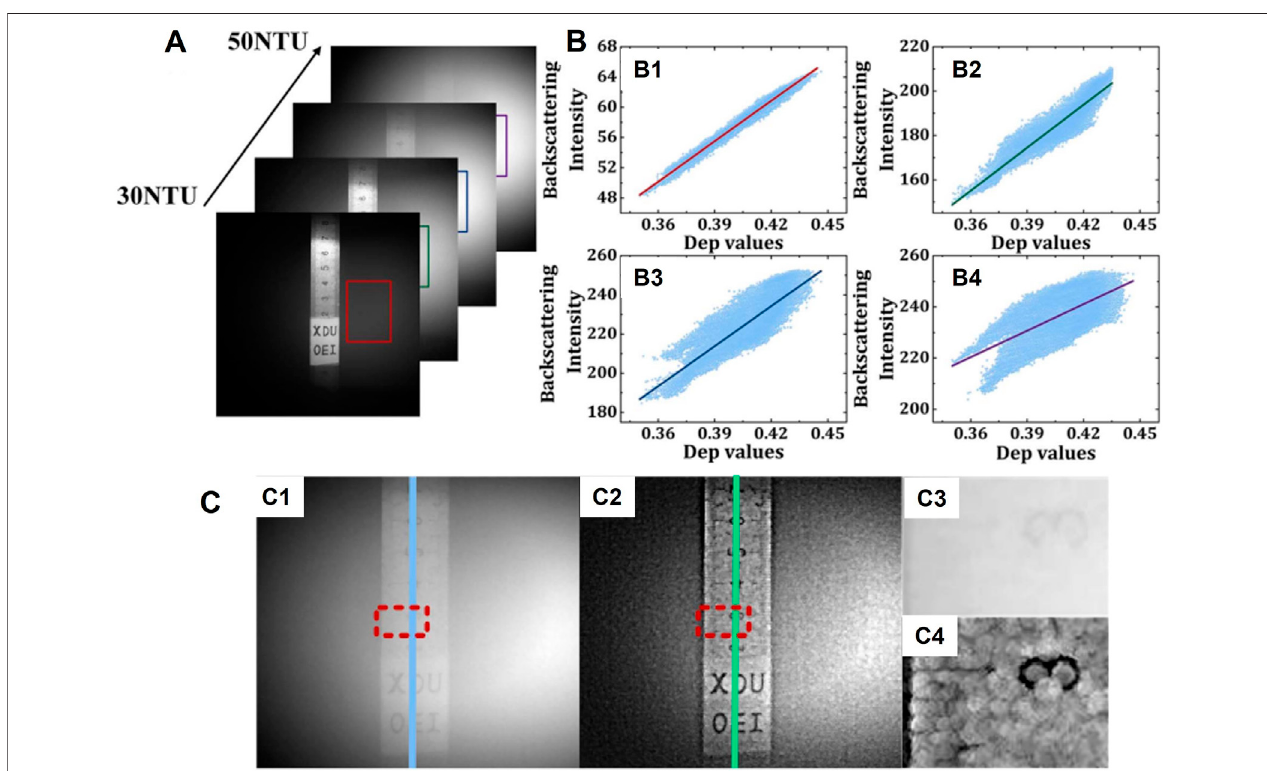
FIGURE 12 | (A) Four measured intensity images at different values of NTU. (B1 – B4) Fitting results of backscattering intensity as a function of Dep values. (C1) Intensity image; (C2) recovered image with the proposed de-scattering method; (C3) and (C4) the zoomed-in view of the region of interest in (C1) and (C2) marked out with red rectangle (reprint from Chinese Laser Press: Chinese Optics Letters [104], copyright